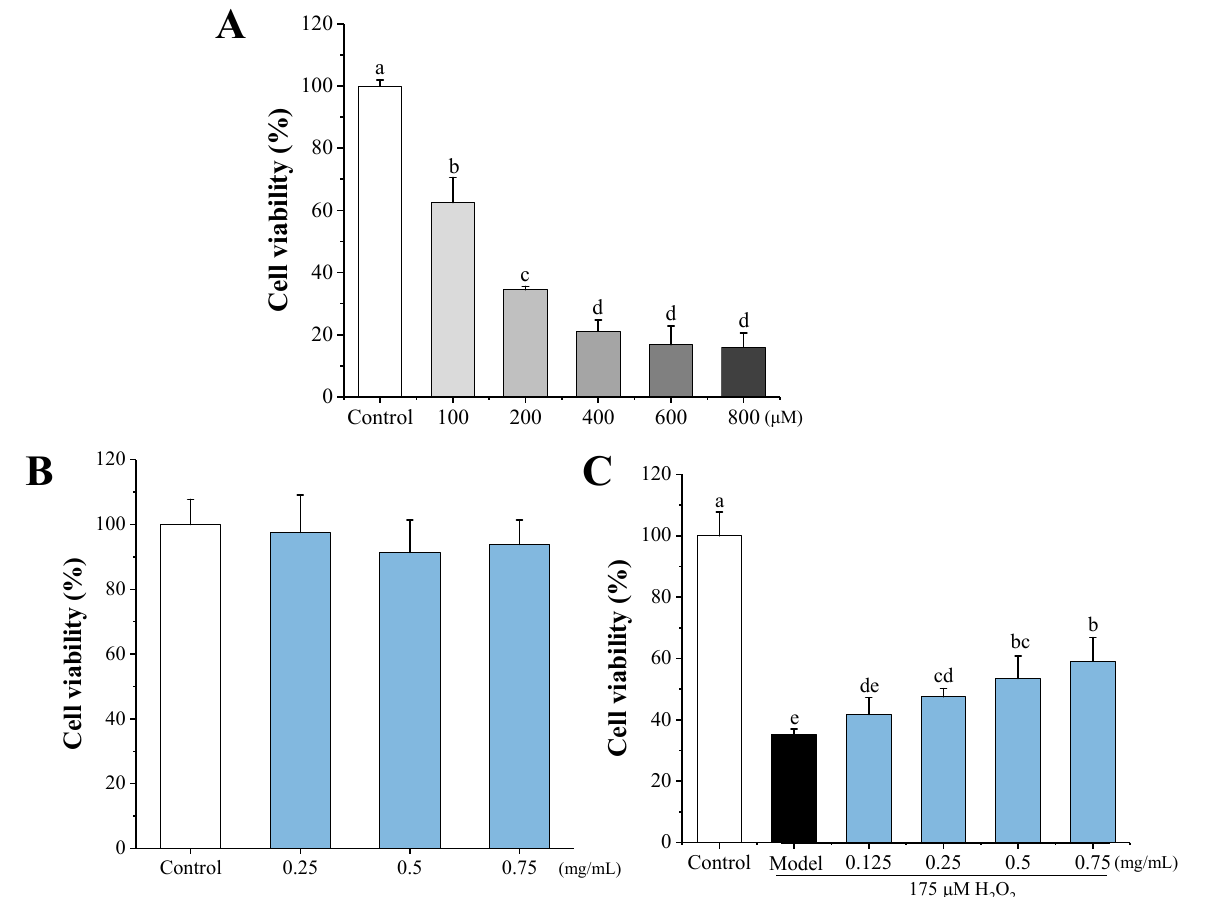
Figure 5. Effects of HEMH-I on the viability of SW1353 cells; ( A ) Effects of H 2 O 2 at different concentrations on SW1353 cell viability; ( B ) Cytotoxicity of HEMH-I; ( C ) Protective effect of HEMH-I on the viability of SW1353 cells under oxidative stress conditions. Note: values are expressed as mean ± SD ( n = 5). Means annotated with different letters for the same parameter are significantly different ( p < 0.05).